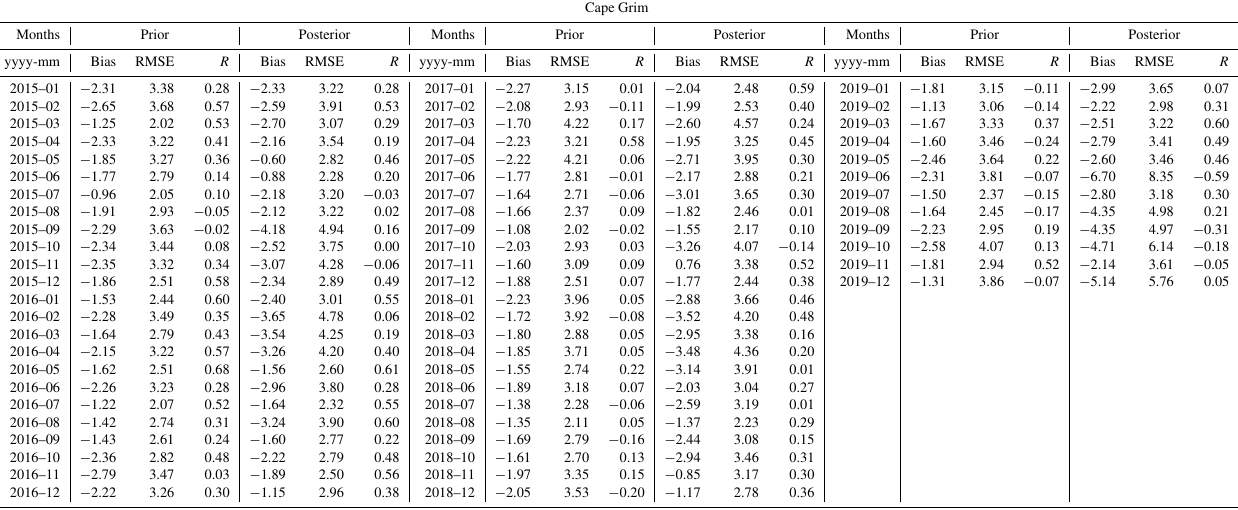
Table G1. Analysis of the residual between CMAQ prior and posterior simulation values and the Cape Grim site for the 2015–2019 period, showing the averaged bias (Bias), root-mean-square error (RMSE), and Pearson coefficient ( R ).